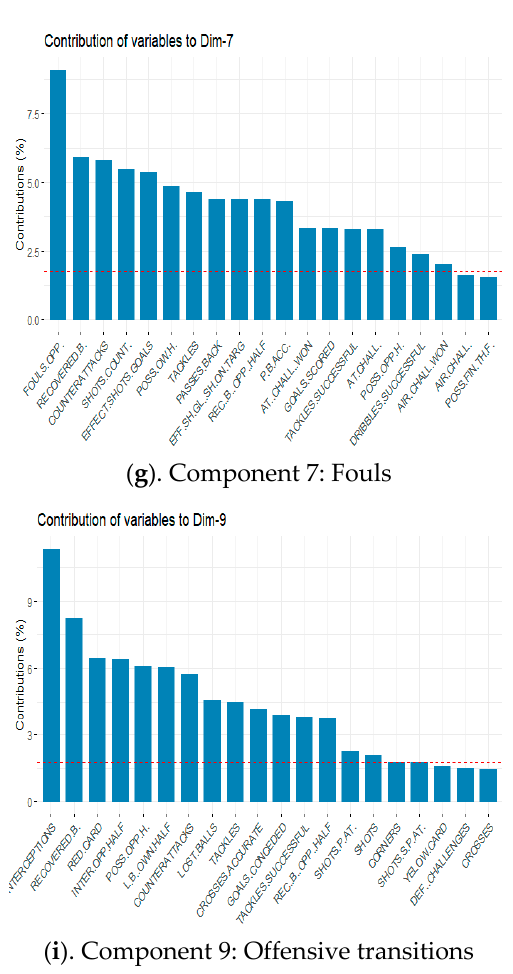
Figure 4. Components and new subjective variables of bottom teams. ( a ): Passes; ( b ): Challenges; ( c ): Shots; ( d ): Attacks effectiveness; ( e ): 1 vs 1; ( f ): Dribbles; ( g ): Fouls; ( h ): Possession balls; ( i ): Offensive transitions.